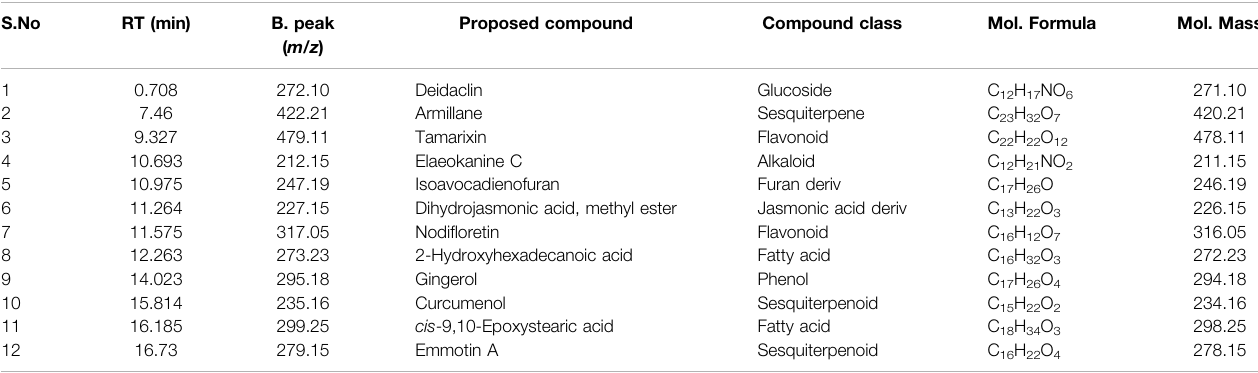
TABLE 2 | UHPLC-MS analysis of the ethanolic extract of C. gigantea (L.) Dryand leaves (positive ionization mode). S.No